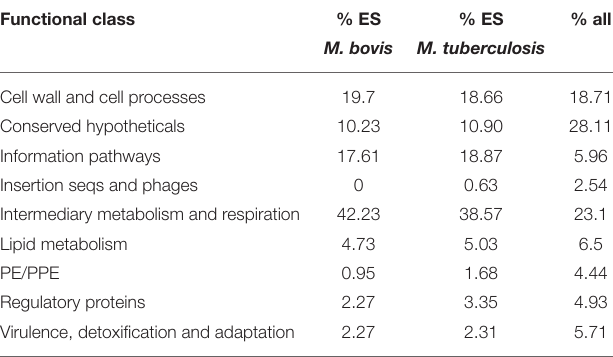
TABLE 4 | Distribution of genes classified as ES across functional class. Functional